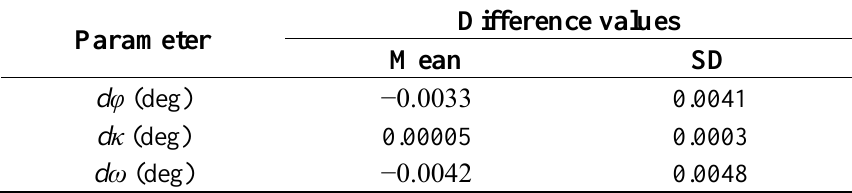
Table 1. Mean and SD angular difference values for the two different SQUAD